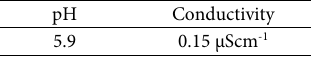
Table 1. The pH and conductivity of the deionized water used for the preparation of Cd